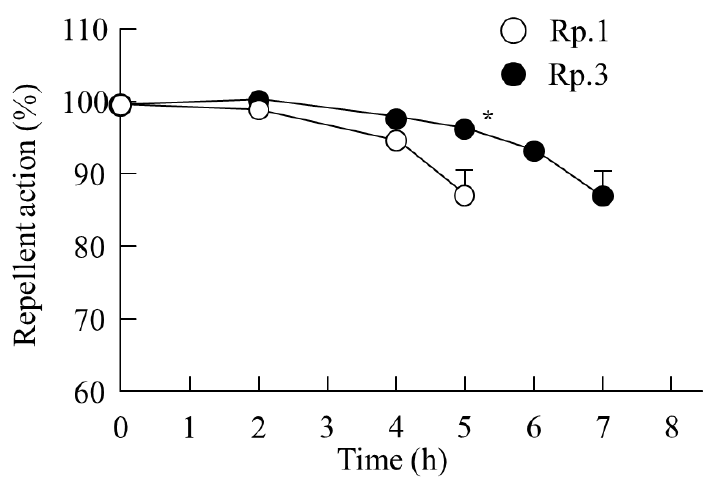
Figure 7. Effect of 0.1% HPβCD on the repellent action of DEET/EtOH (10:40%). The compositions of Rp. 1 and Rp. 3 formulations are shown in Table 1. n = 6. * p < 0.05 vs. Rp. 1 formulation. The addition of 0.1% HPβCD prolonged the repellent effect of DEET/EtOH.